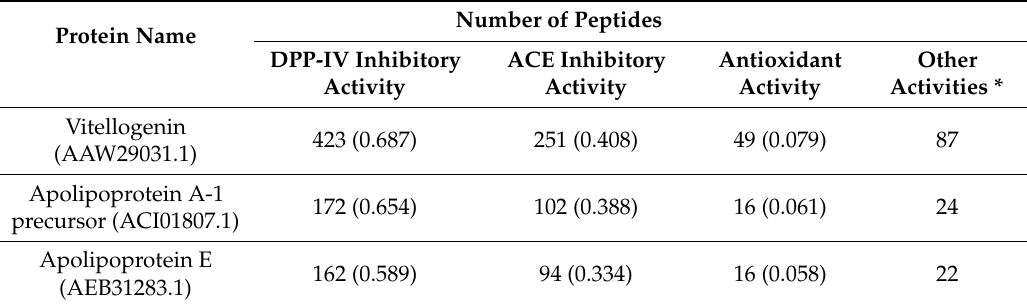
Table 2. Prediction of potential bioactive peptides of giant grouper roe protein by BIOPEP-UWM database (accessed on 30 October 2018).